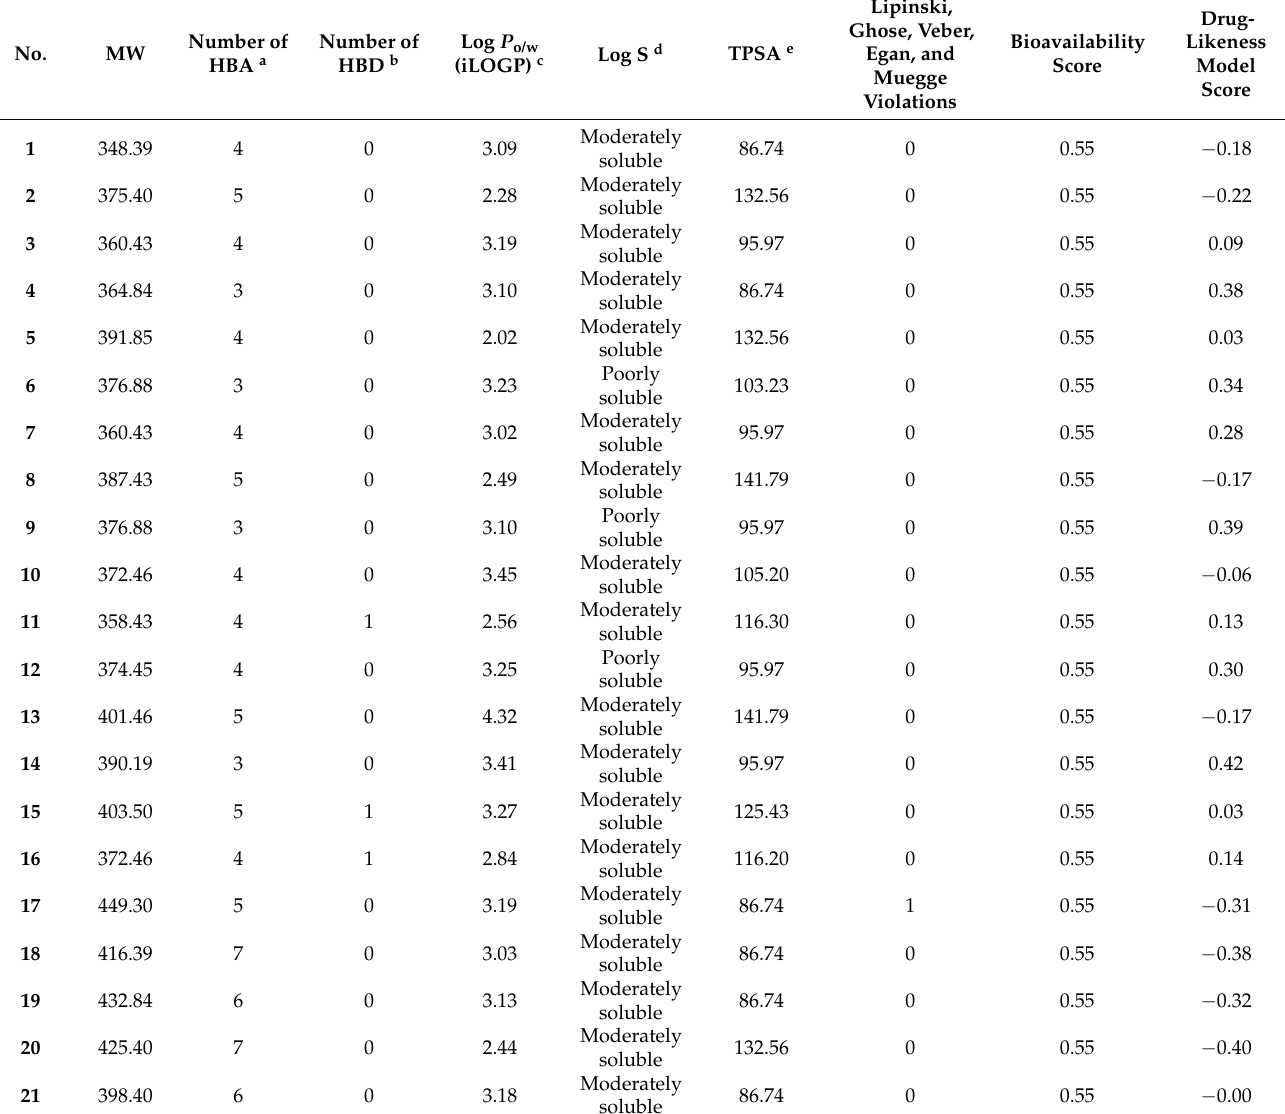
Table 8. Drug-likeness predictions and physicochemical-pharmacokinetic/ADME properties of tested